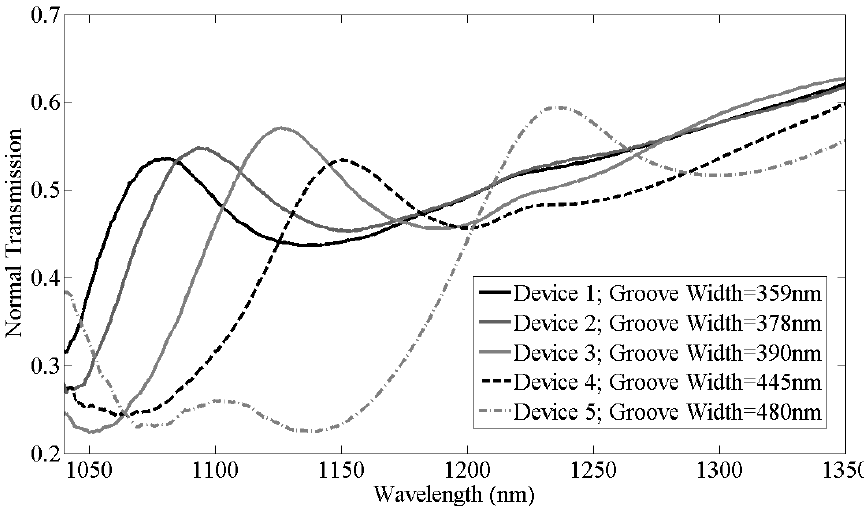
Figure 7. Normal transmission spectra of grating devices with different groove